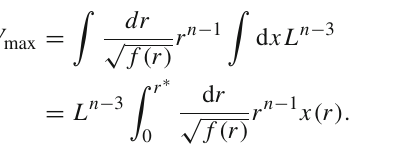
Fig. 15 Five dimensional SAdS black holes showing the behavior of fidelity susceptibility versus pressure. We address the temperatures of this higher dimensional black hole. We indicate that the association of fidelity susceptibility to thermodynamic volume is universal for any number of